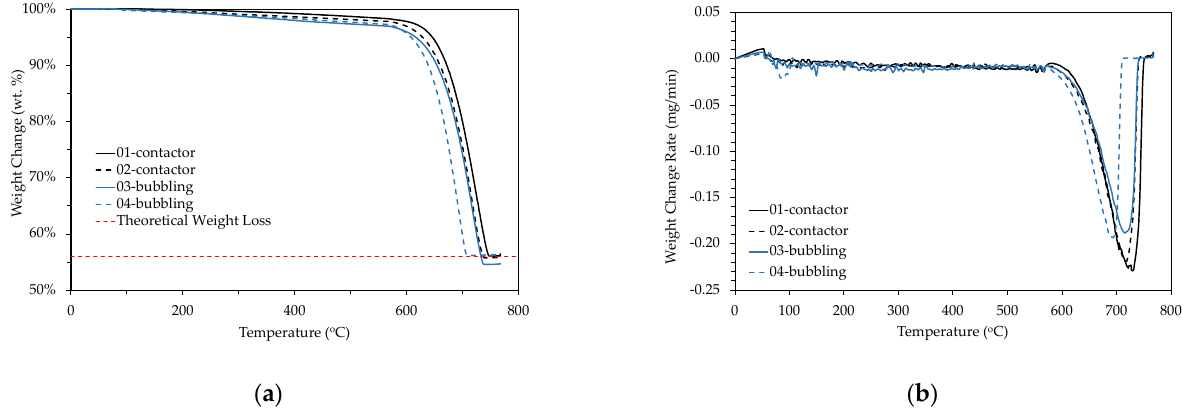
Figure 5. TGA analysis results ( a ) % weight change; ( b ) weight change rate.